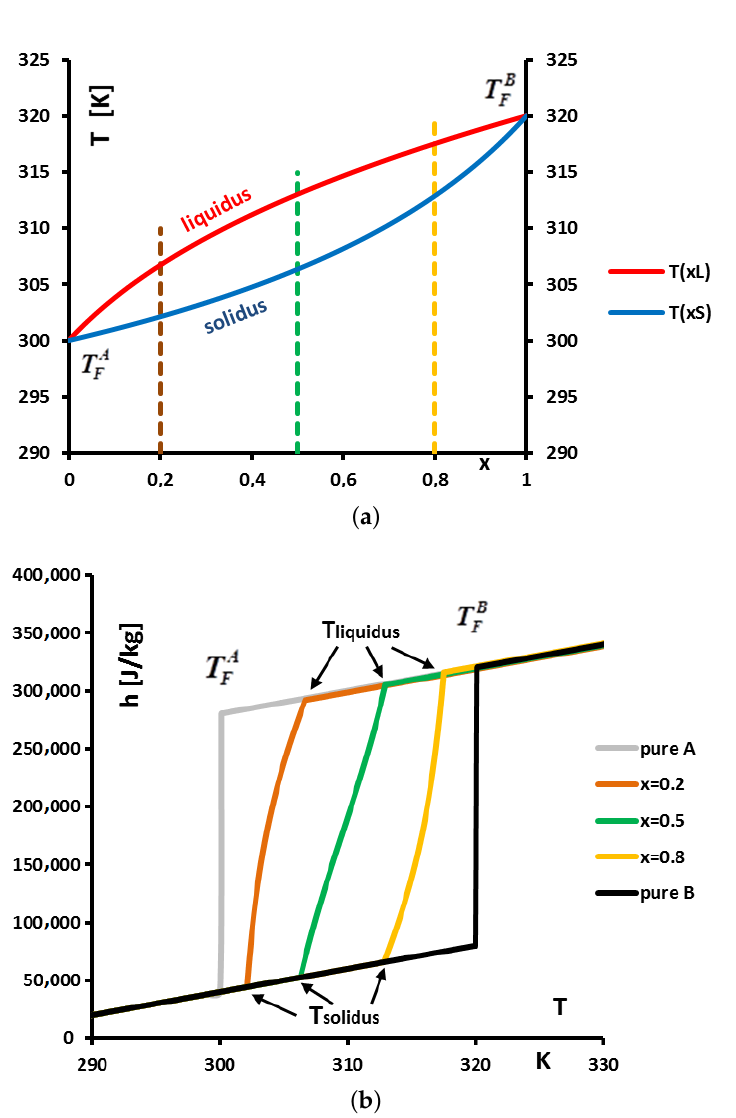
Figure 25. Phase diagram and specific enthalpy for three concentrations for a binary presenting a solid solution. ( a ) Phase diagram; ( b )